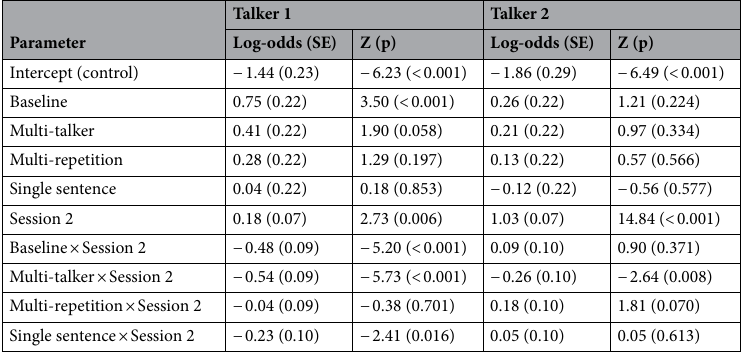
Table 6. Prediction models for time-compressed speech recognition as a function of group, talker and session (including group × session interactions).